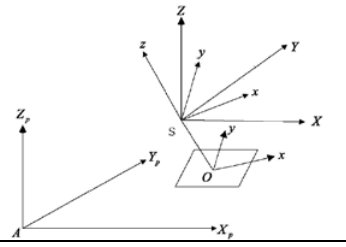
Figure 8. Photogrammetric coordinate system